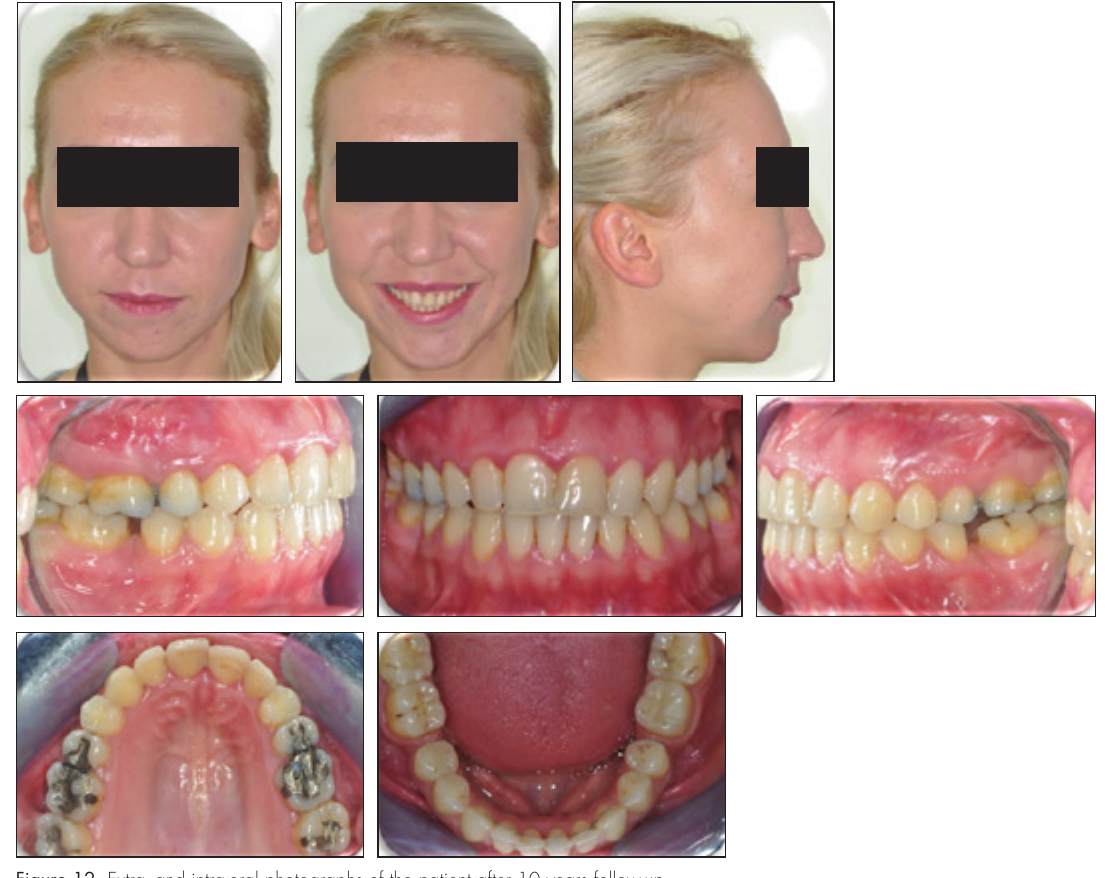
Figure 12. Extra- and intra-oral photographs of the patient after 10 years